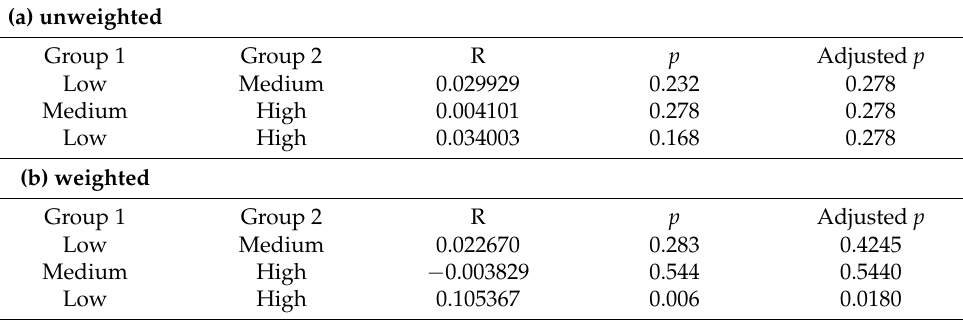
Table 3. Pairwise comparisons of beta diversity between samples using ( a ) unweighted and ( b ) weighted normalized UniFrac distances, where adjusted p -value was computed following the Benjamini–Hochberg